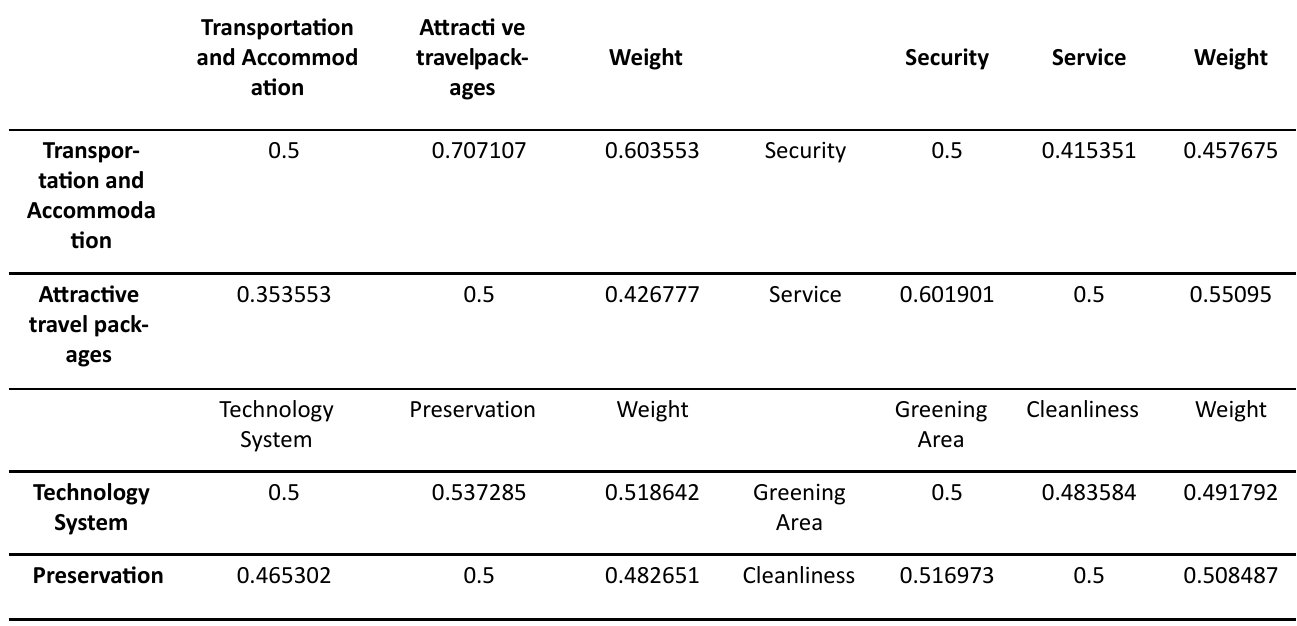
Table 8. The Results of The Joint Priority Values Sub-Criteria